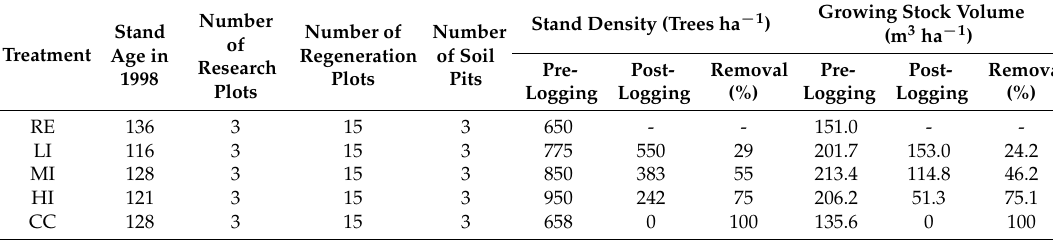
Table 1. Stand characteristics of the treatments before and after the logging operations in 1998. The growing stocks were estimated using a yield table developed by Dorjsuren et al. [44]. Stand age was derived from wood cores analyzed at the National University of Mongolia in Ulaanbaatar. RE